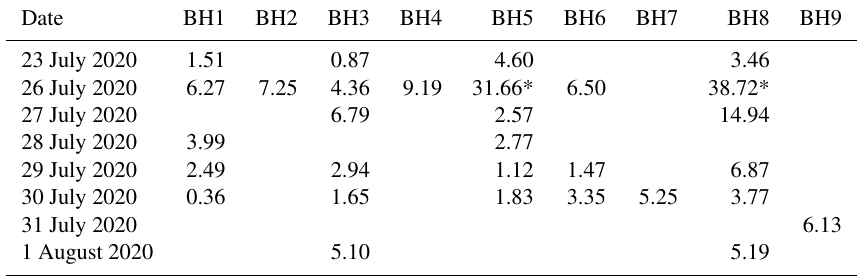
Table 3. Overview of average flow velocities measured on various dates in all the boreholes along the transect (in mh − 1 ). Values represent average velocities measured on a specific date: in most cases three experiments were carried out per borehole per day, but only the average of these velocities is displayed here. Values denoted with an asterisk ( ∗ ) are likely overestimations of the actual flow velocity due to sensor